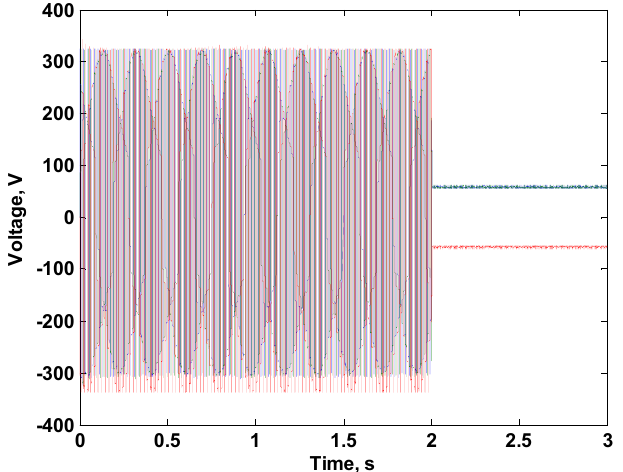
Figure 25. Applied Voltage on the 3-Phase Induction Motor, Braking Occurs at 2 s.